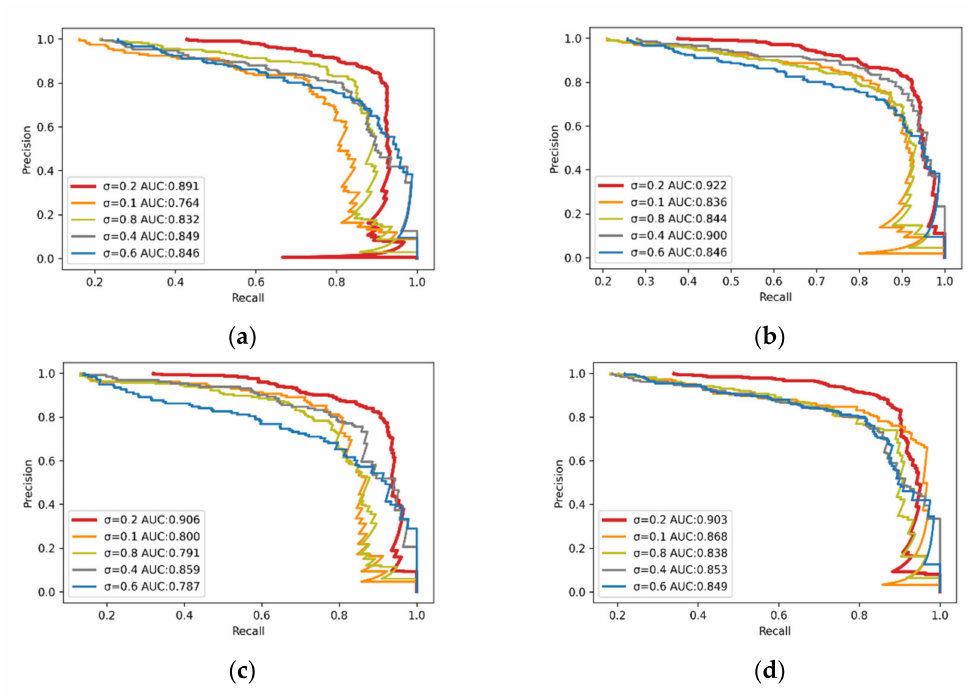
Figure 9. PR curves of DR-VAE model with different distribution capacity attenuation factor δ and pseudo-random defect scales d : ( a ) No random pseudo-defects; ( b ) d = 15; ( c ) d = 20; ( d ) d =